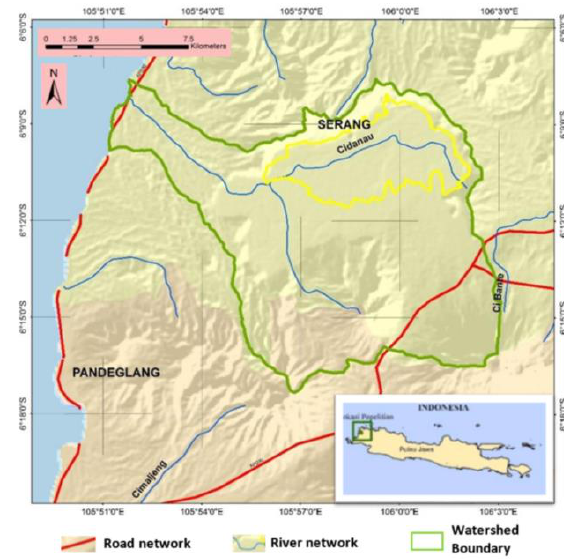
Figure 1. Study area: Cidanau Watershed